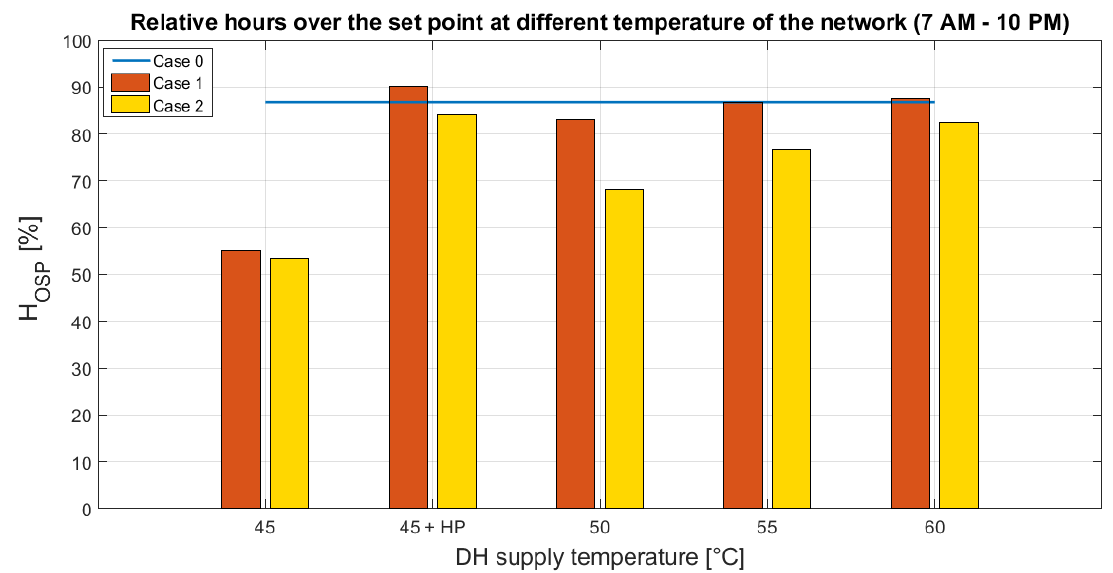
Figure 8. Comparison of annual performance of HP and different supply temperatures